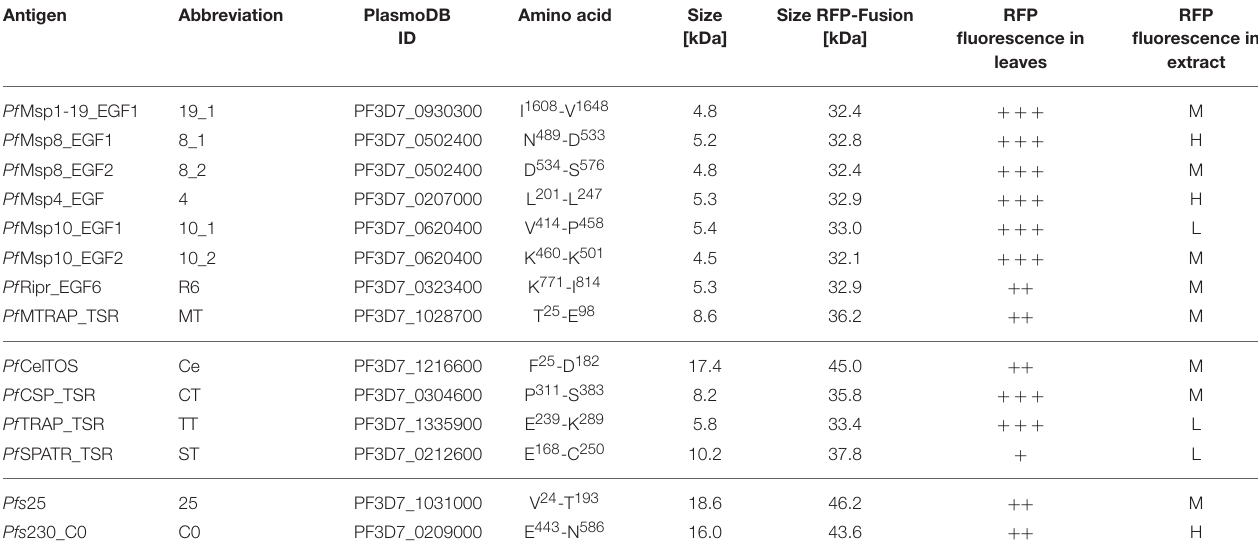
TABLE 1 | Overview of P. falciparum antigens and antigen domains.